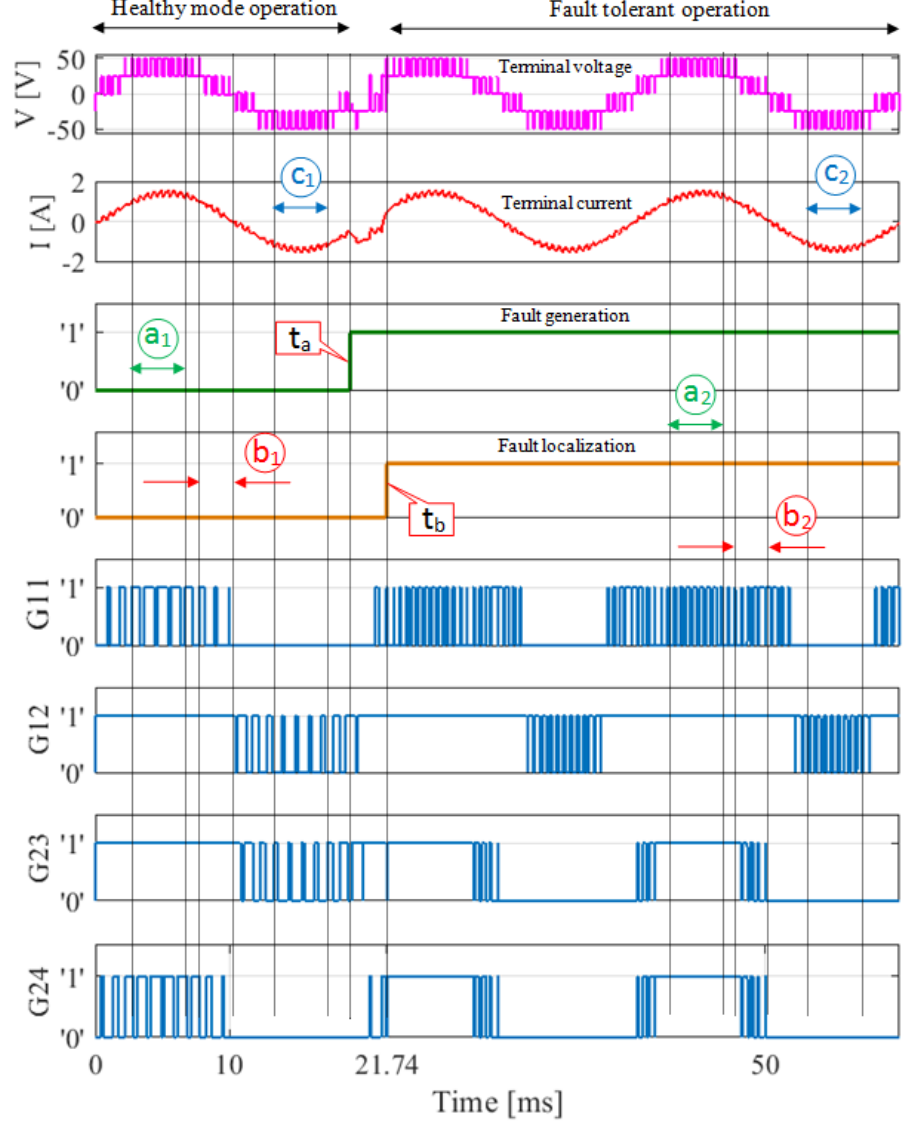
Figure 8. Simulation results for fault-tolerant operation of the inverter in the case of a short-circuit fault event in S21.